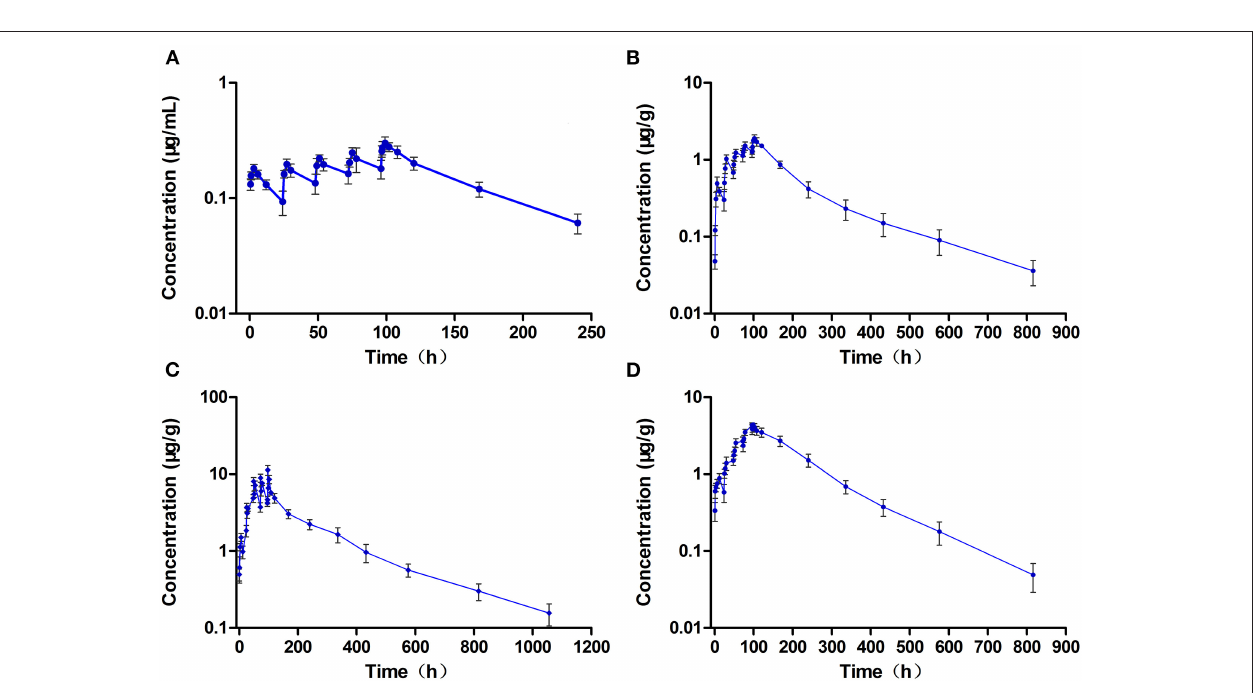
127 h, 103 h, and 129 h, respectively. Therefore, it can be seen that CIP was eliminated faster in the plasma and kidney than ENR, while the other tested tissues were the